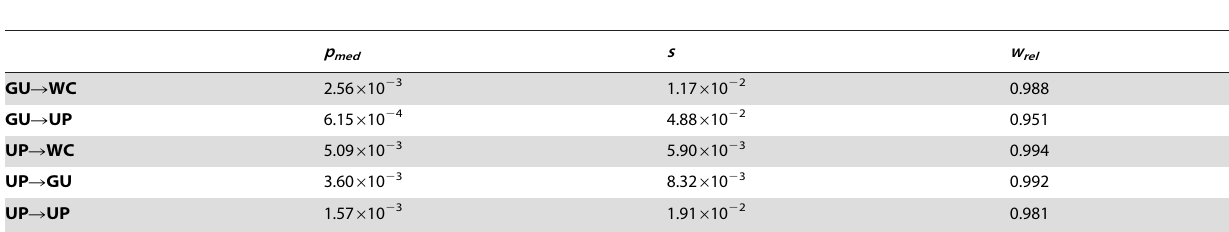
Table 3. Median frequencies, selection coefficients, and relative fitnesses of second-site WC replacement polymorphisms in the HIV-1